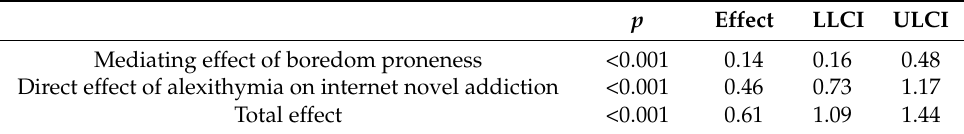
Table 3. The mediating role of boredom proneness.